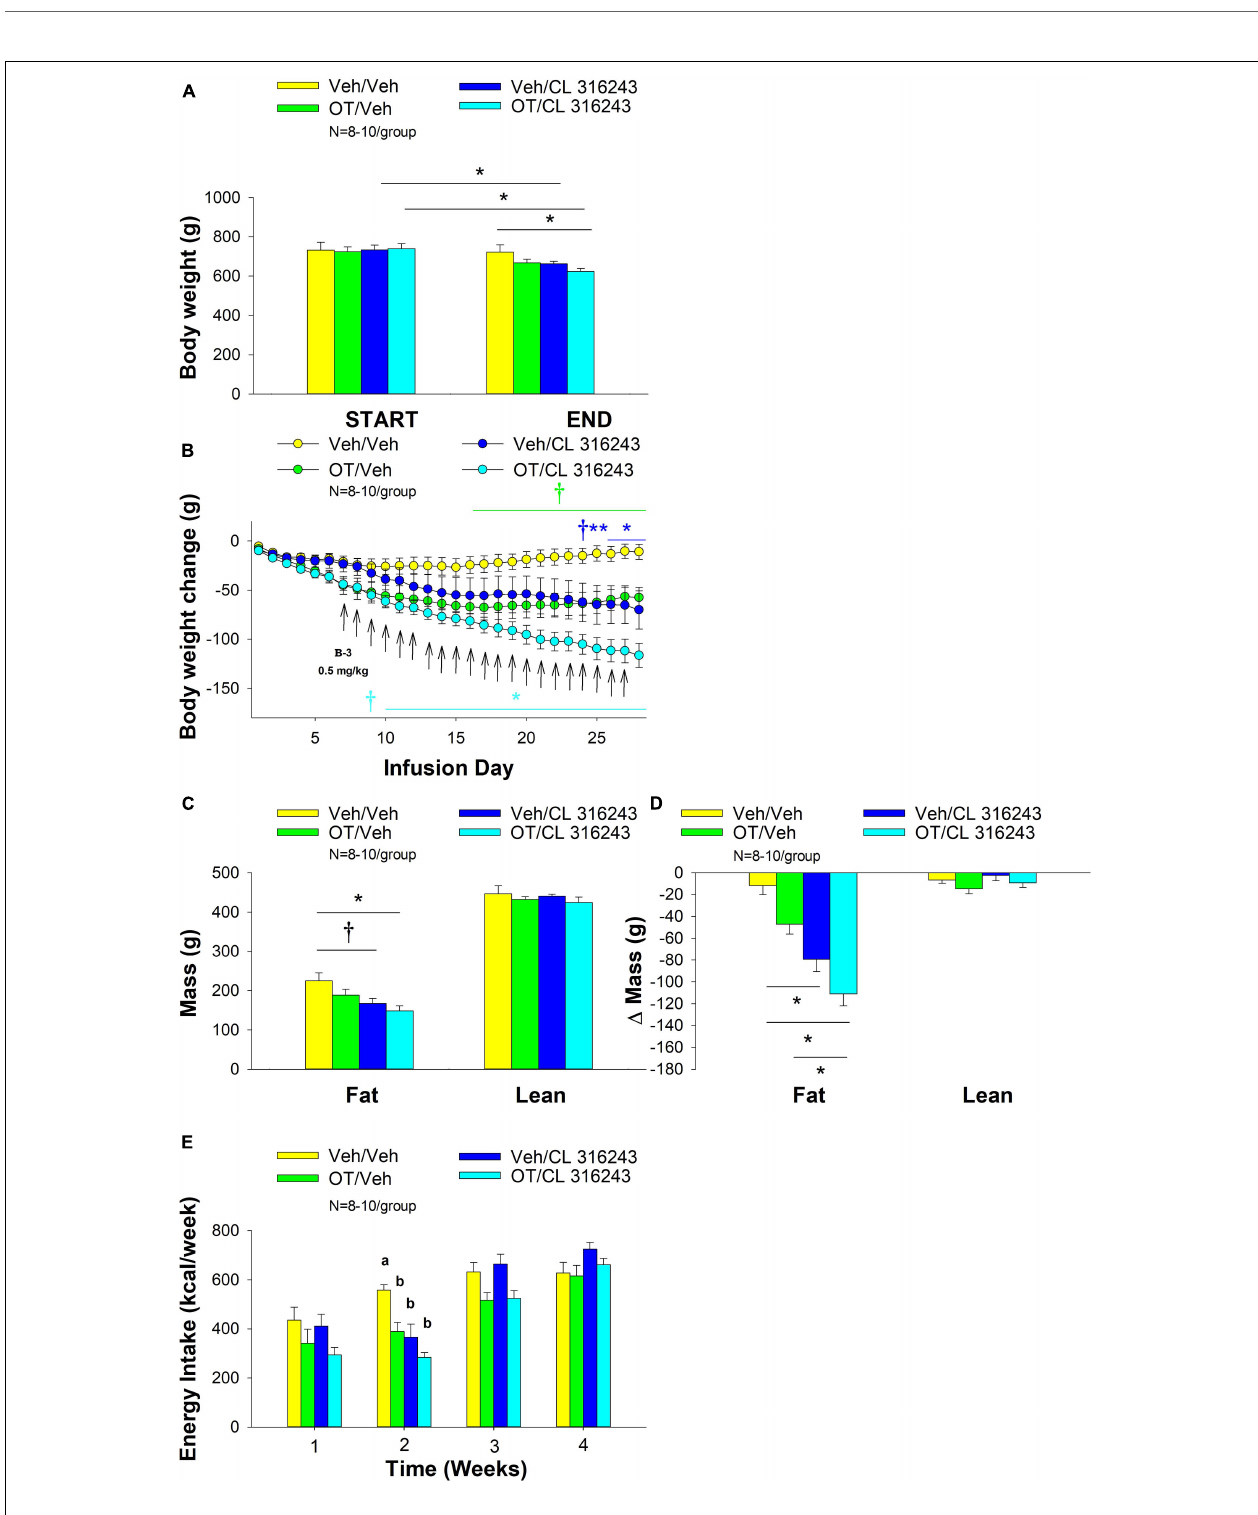
FIGURE 3 | (A–E) Effect of chronic 4V OT infusions (16 nmol/day) and systemic beta-3 receptor agonist (CL 31643) administration (0.5 mg/kg) on body weight, body adiposity and energy intake in male DIO rats. Ad libitum fed rats were maintained on HFD (60% kcal from fat; N = 8–10/group) for approximately 8 months prior to receiving continuous infusions of vehicle or OT (16 nmol/day) in combination with a single dose of CL 316243 (0.5 mg/kg). (A) Change in body weight in HFD-fed DIO rats; (B) Change in body weight gain in HFD-fed DIO rats; (C) Change in fat mass and lean mass in HFD-fed DIO rats; (D) Change in relative fat mass and lean mass in HFD-fed DIO rats; (E) Weekly energy intake (kcal/week) in HFD-fed DIO rats. ↑ indicate 1 × daily injections. Different letters denote significant differences between treatments. (B) Colored bars represent specific group comparisons vs. vehicle. Data are expressed as mean ± SEM. * P < 0.05, ** P = 0.05, † 0.05 < P < 0.1 vs. vehicle or baseline (pre-treatment; A